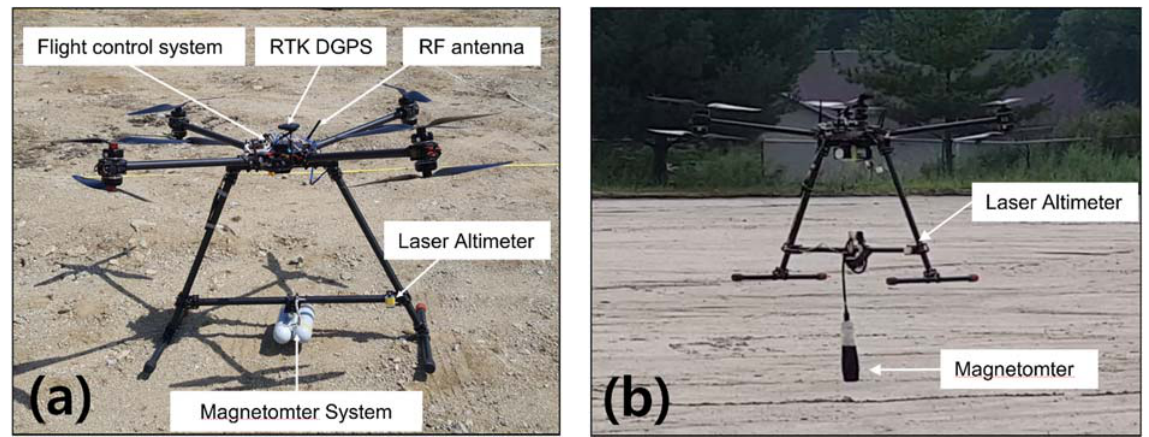
Figure 2. Photograph of the drone-fitted magnetometer system before ( a ) and after ( b ) improvement.